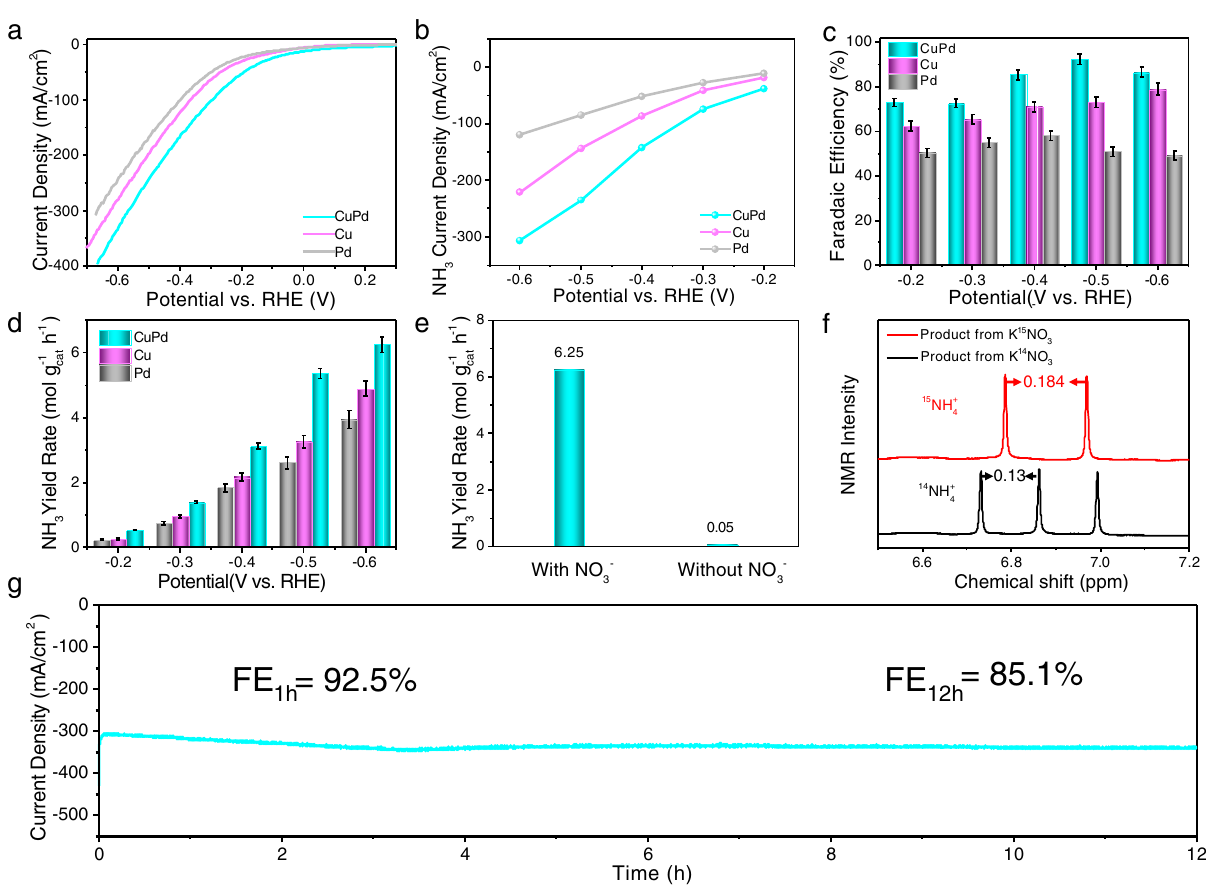
Fig. 5 Electrocatalytic NO 3 RR performance of the ordered CuPd nanocubes. a Linear scan voltammetry curves of ordered CuPd nanocubes, Cu nanocubes, and Pd nanocubes normalized to the geometric area. b Partial NH 3 current densities normalized to the geometric area. c FE of NH 3 at different potentials, The error bars correspond to the standard deviation from three independent measurements. d NH 3 yield rate of ordered CuPd nanocubes, Cu nanocubes, and Pd nanocubes at various potentials. e The yield rate of NH 3 with or without nitrate at − 0.6 V vs. RHE. f NMR spectrum of the products generated during the electrocatalytic NO 3 RR with ordered CuPd nanocubes in 1 M K 15 NO 3 or 1 M K 14 NO 3 at − 0.5 V vs. RHE. g Stability test by running the CA measurement on the ordered CuPd nanocubes at − 0.5 V vs. RHE for 12